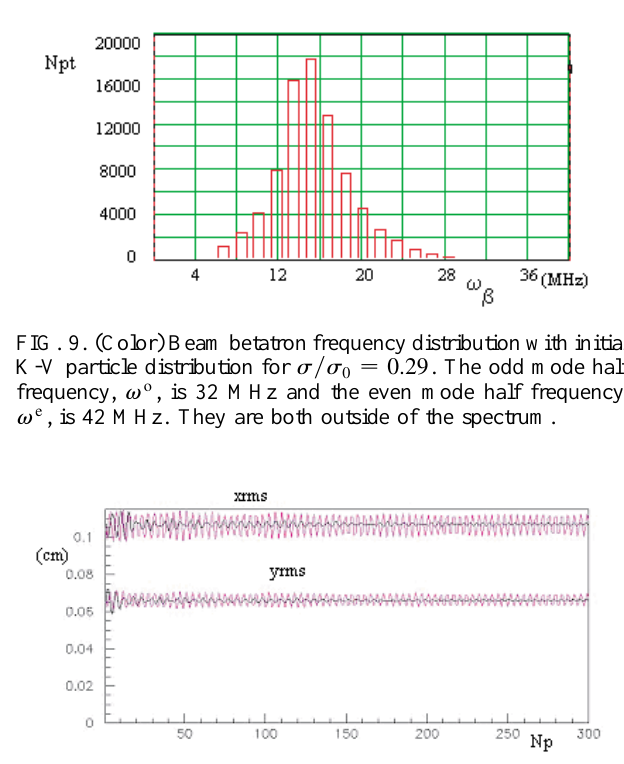
FIG. 10. (Color) The rms envelope oscillation damping with initial Gaussian particle distribution for s (cid:5) s 0 (cid:2) 0.29 (cid:1) ` (cid:2) 200 mA (cid:2) . The black line refers to the odd mode and the ma- genta line to the even mode.